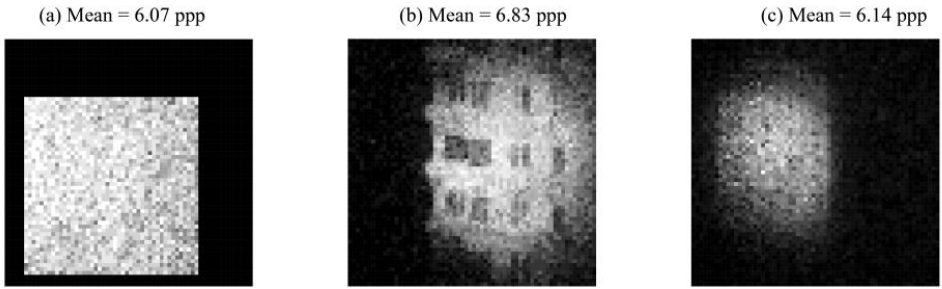
Figure 6. The number of detected signal photons per pixel (normalized) for the long-range imaging scenes in Figure